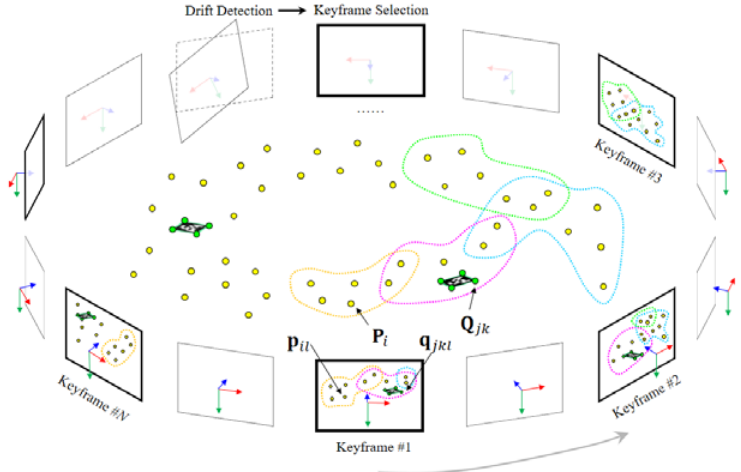
Figure 12. Hybrid bundle adjustment fused with natural features and markers for global pose op- Hybrid bundle adjustment fused with natural features and markers for global timization. pose